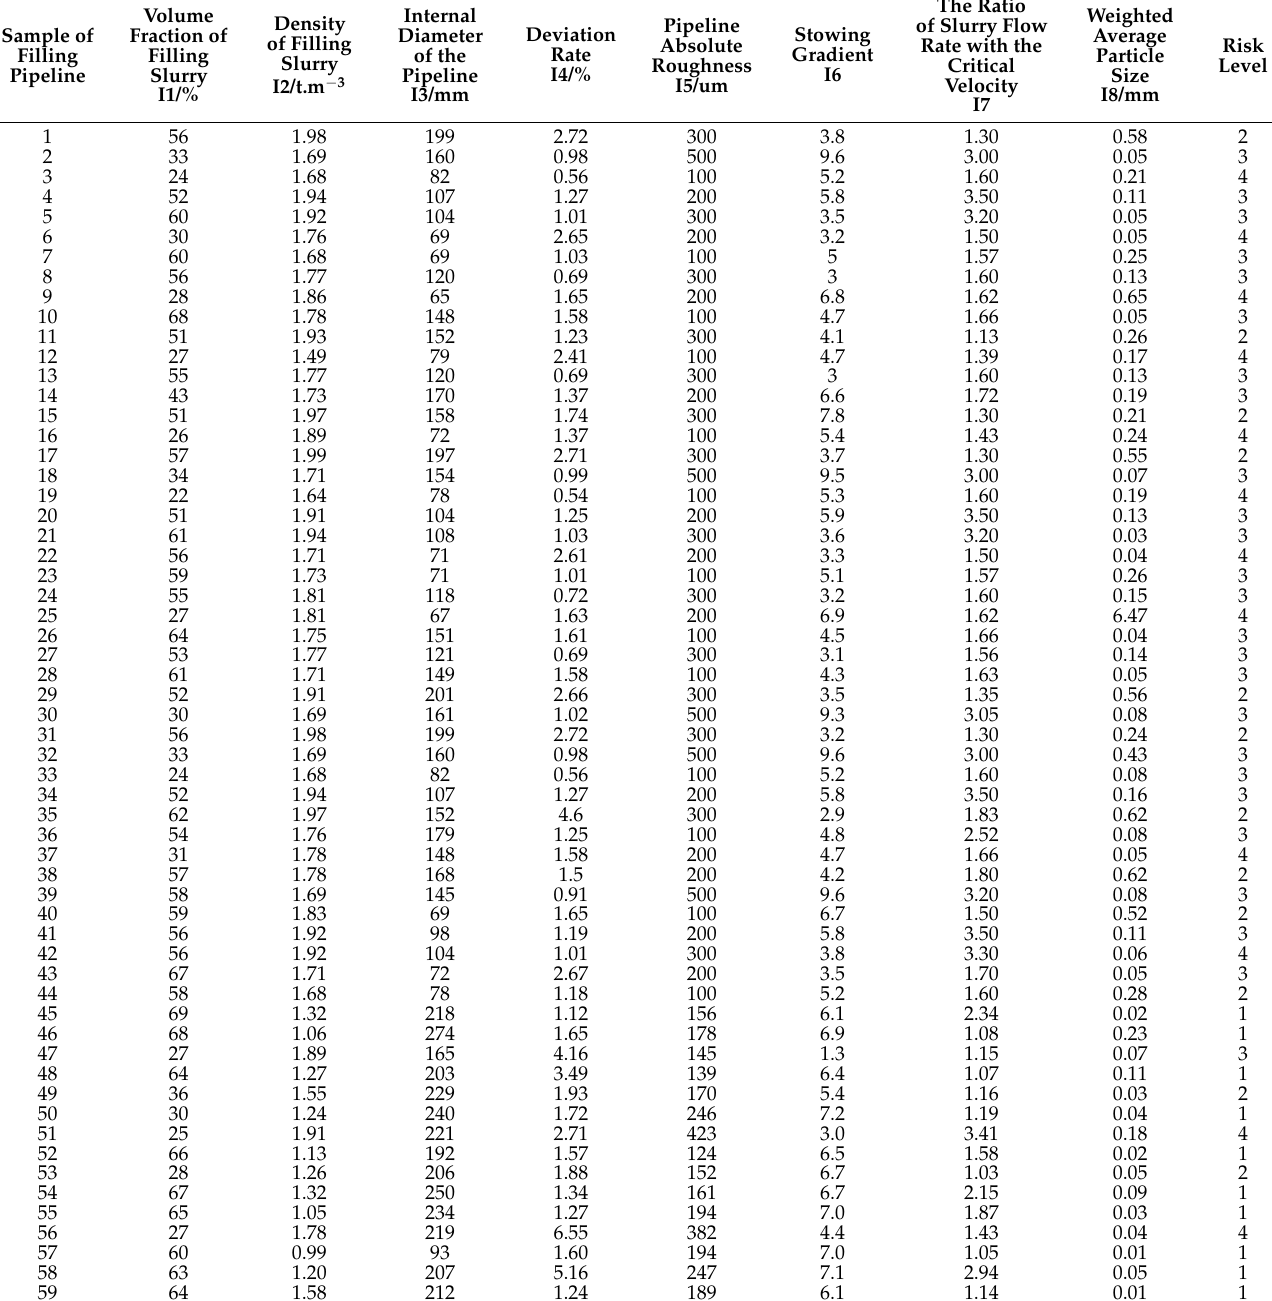
Table 2. The statistical information of backfilling pipeline invalidation risk influence factors and